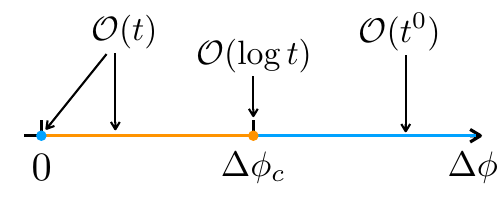
Figure 34 . The leading time evolution of the pseudo entropy in the phase transition induced by ∆ φ